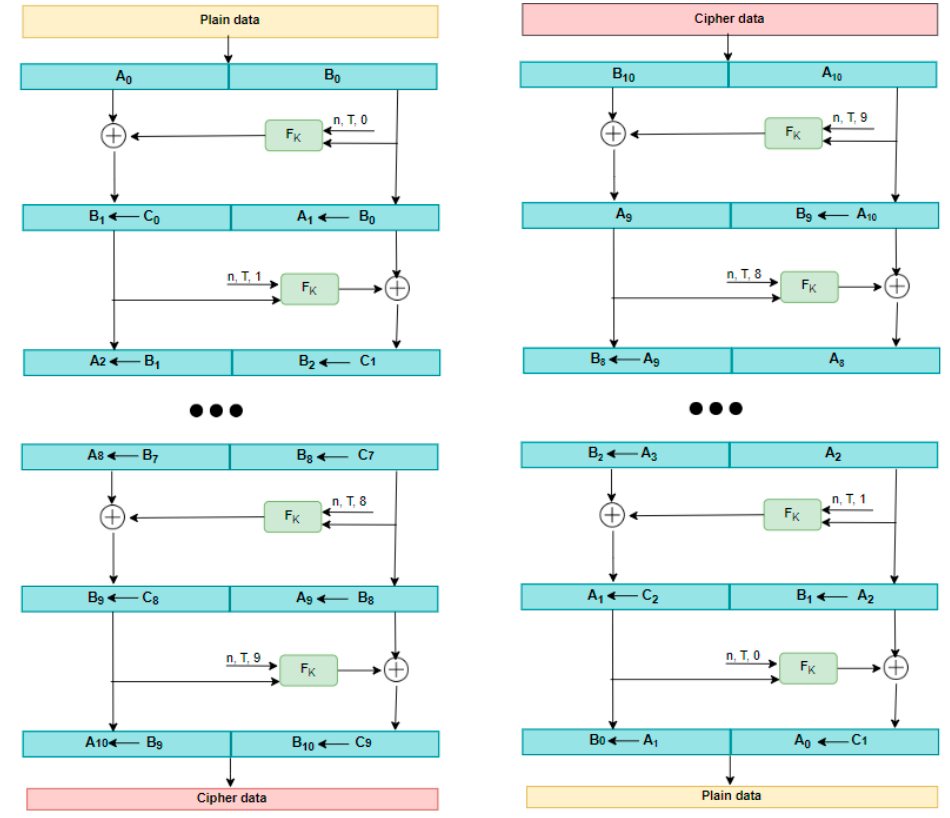
Figure 1. Encryption ( left ) and decryption ( right ) structure of FF1 and FF3-1 [23]. Two strings of characters serve as the input (and output) data for each round; for FF1 and FF3-1, these strings will be numerals. The two strings are equal in length, and n rep- resents the overall number of characters. The round function, denoted by FK in Round i, is applied to one of the input strings, marked by Bi, with the extra inputs of length n, tweak T, and round number i. (In Figure 1, these three extra inputs (n, T, and i are shown as the super-posed arrow with the proper values for i.) By applying modular addition— indicated by the plus sign ⊕ —on the numbers the strings stand for, the result is utilized to change the other string, denoted by Ai. A temporary variable called Ci is used to name the string that represents the outcome number. For the following round, the names of the two components are switched, resulting in the modified Ai, or Ci, becoming Bi + 1 and Ai becoming Bi + 1. The Feistel structure for encryption and decryption is nearly interchangeable. There are three variations: I. The order of the round indices is changed; II.